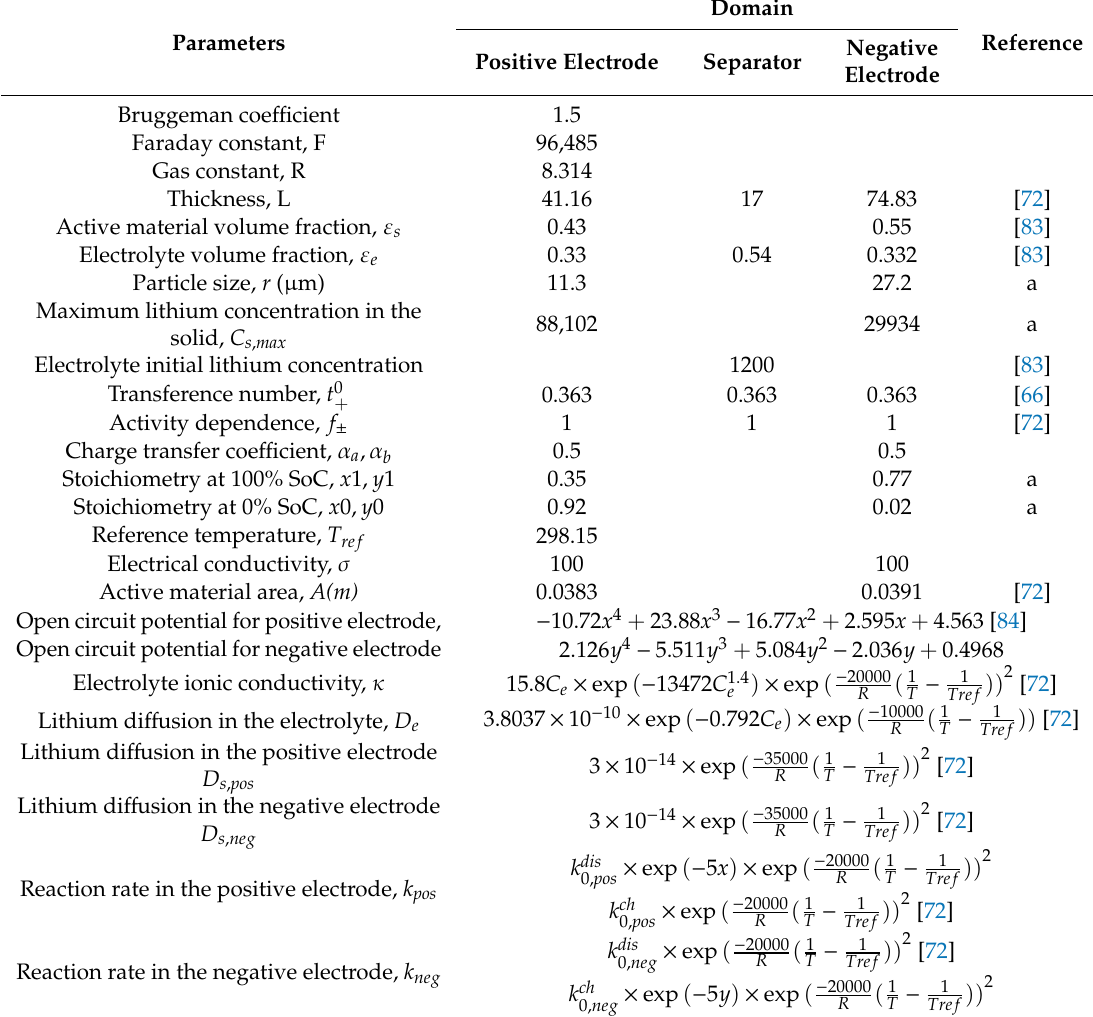
Table A1. Pseude2-dimensional Battery Model